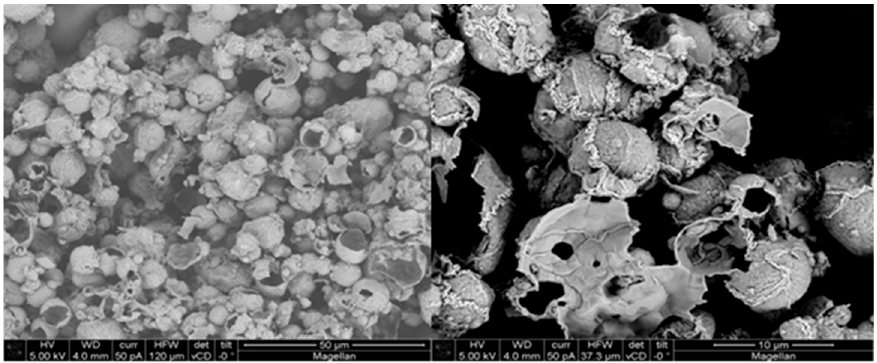
Figure 27. Two SEM images of aluminum particle clusters heated by dropping onto hot Ni-chrome ribbon.